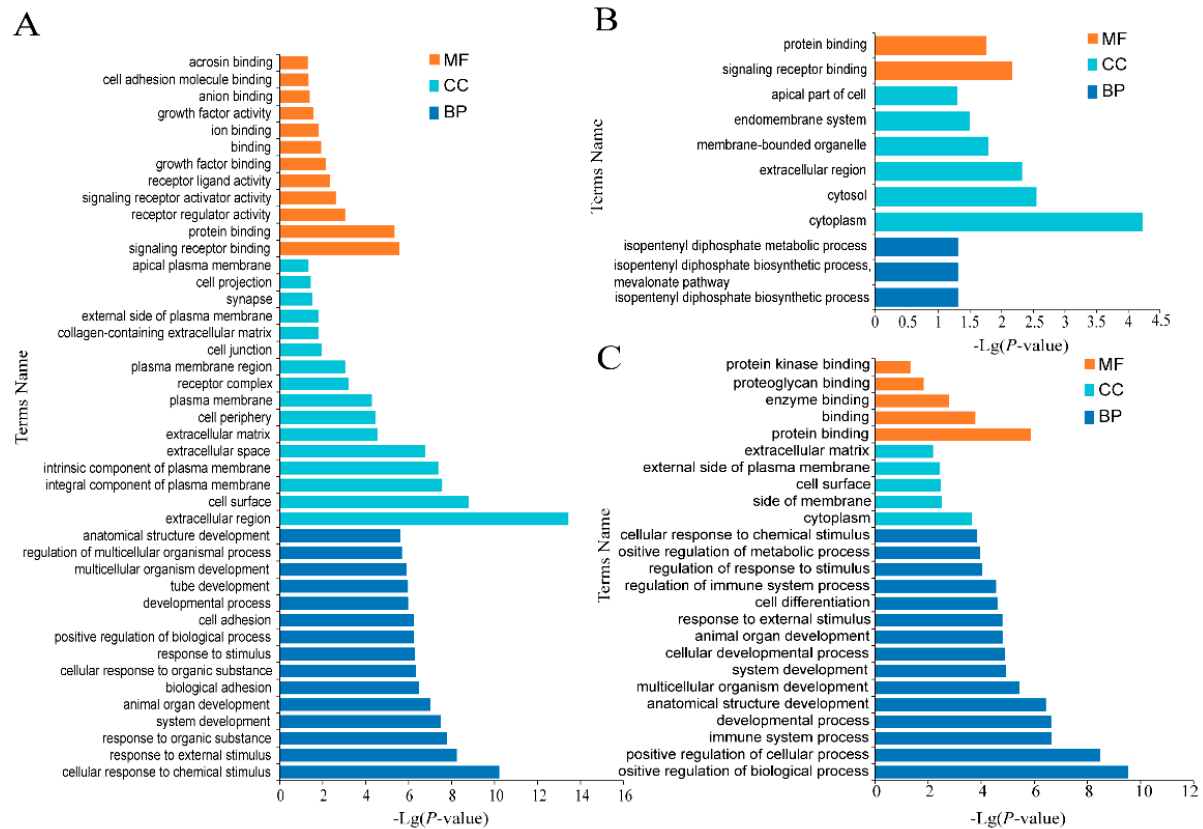
Figure 6. Enrichment analyses of ovary mRNAs. ( A ) Enriched GO terms of luteal phase, ( B ) Enriched GO terms of proestrus, ( C ) Enriched GO terms of estrus. Different bar chart colors represent different items. Dark blue represents BP, light blue represents CC, and orange indicated MF. Table 2. The significantly enriched pathways of KEGG analyzes.